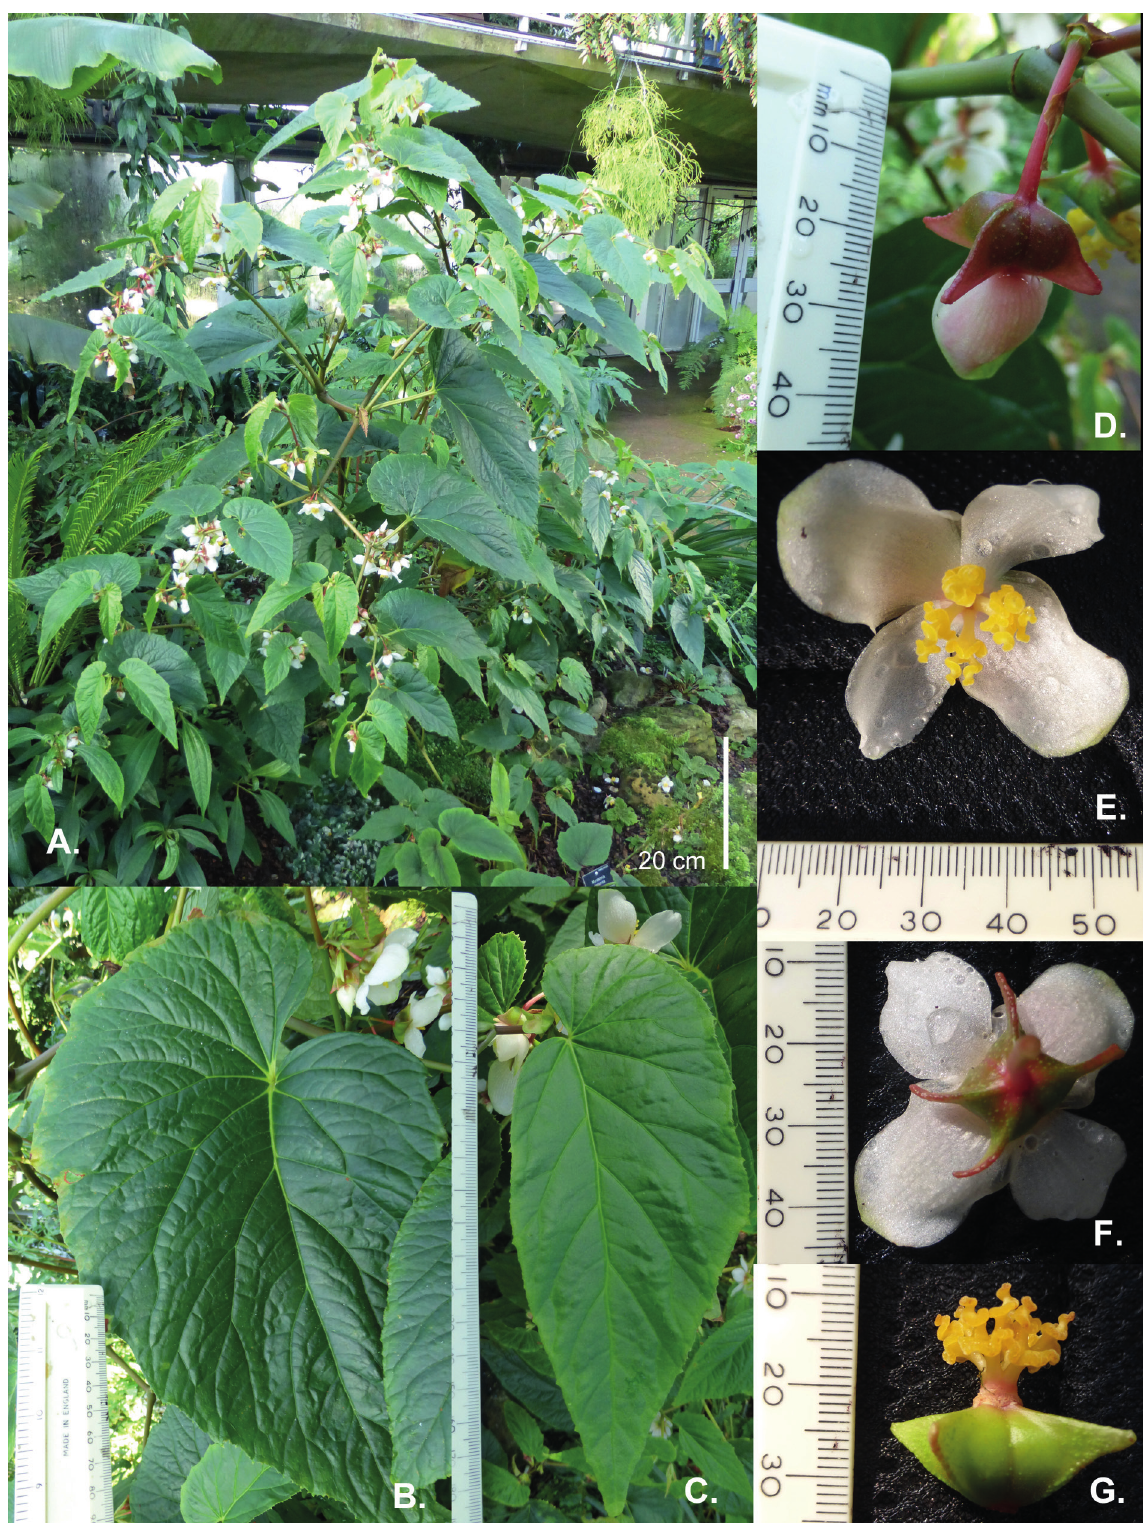
Fig. 7. Begonia acetosella Craib. A . Plant habit. B–C . Leaf variation. D . Female bud. E . Female flower. F . Reverse of flower. G . Styles. Photographs by Rebecca Camfield of a plant in cultivation at the Royal Botanic Garden Edinburgh (accession